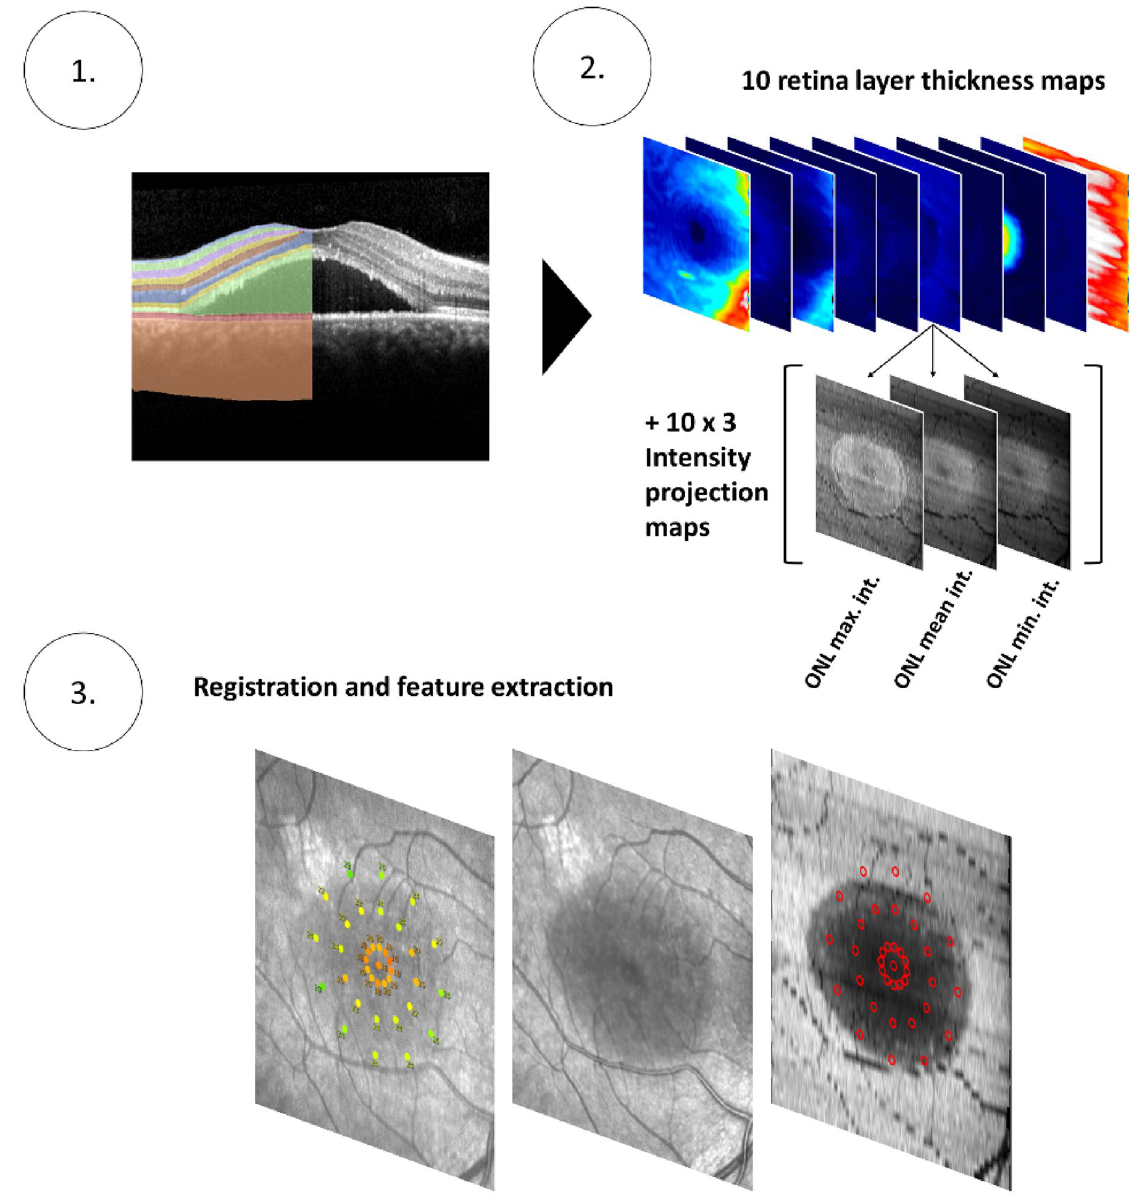
Figure 3. Image segmentation and feature extraction. The spectral domain-optical coherence tomography (SD-OCT) volumes were segmented using a custom deep-learning based pipeline (panel 1). Of note, subretinal fluid was counted toward the outer segment compartment. Subsequently (panel 2), thickness maps as well as 3 intensity projections per retinal layer were generated (total of 40 en face maps). The intensity projects depict the maximum, mean or minimum reflectivity within a given layer along each A-scan. Last (panel 3), the MAIA data was registered to the SD-OCT volume with the help of the co-acquired infrared reflectance image based on landmarks such as vascular bifurcations. This allowed to extract retinal layer thickness and reflectivity values corresponding precisely to the stimulus position and